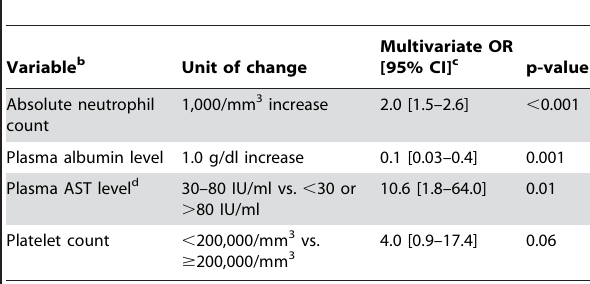
Table 4. Multivariate logistic regression model for leptospirosis vs. dengue a